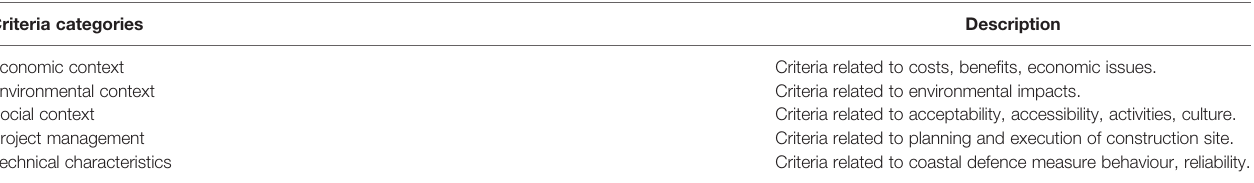
TABLE 3 | Criteria categories presented to participants.